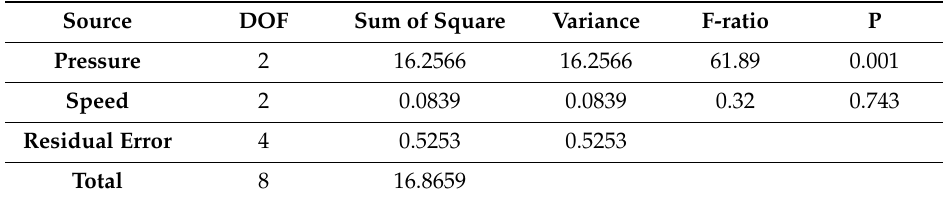
Table 3. Analysis of variance for SN ratios.